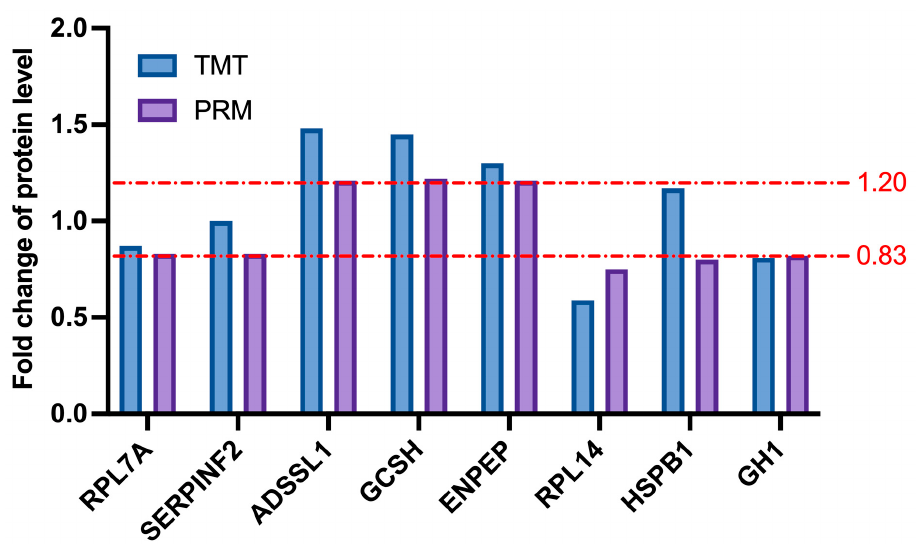
Figure 10. Expression patterns of selected differentially expressed proteins with PRM validation and TMT analysis. From top to bottom, the two dotted lines represent 1.2-fold and 0.83-fold, re- spectively.